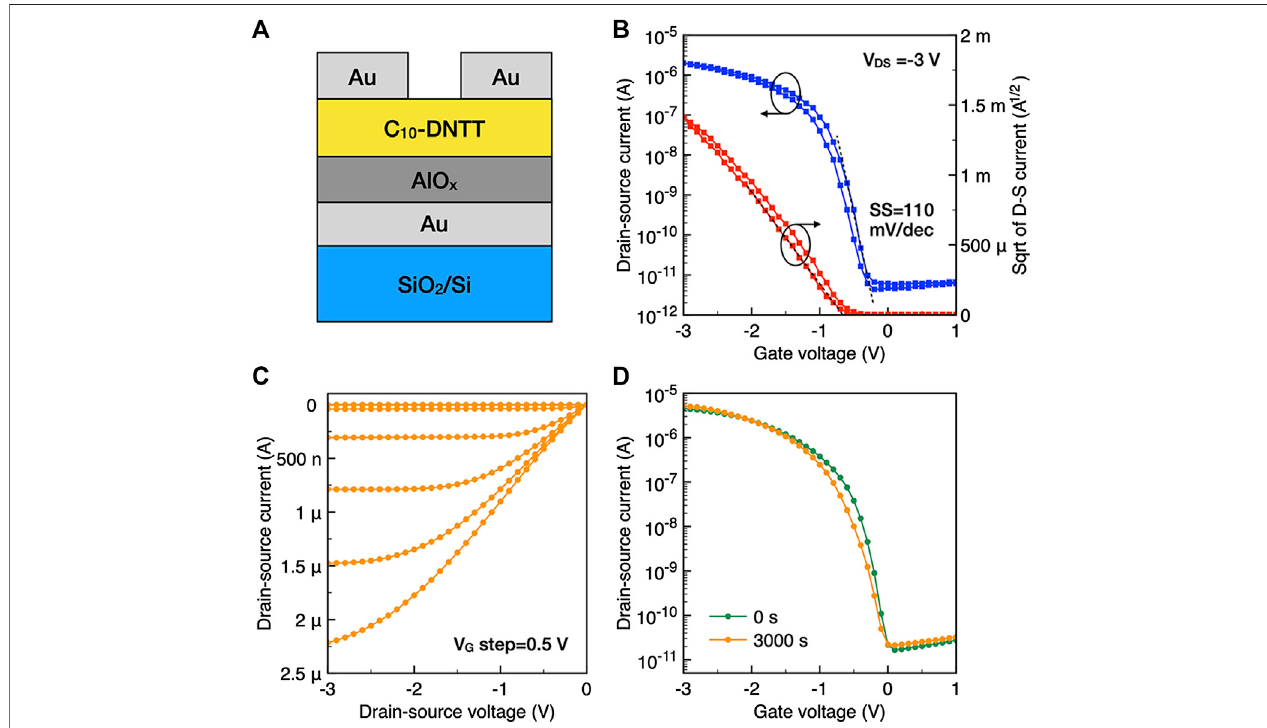
FIGURE 4 | (A) Schematic drawing of the organic transistor device structure. (B) Transfer I-V curve and square root of the drain-source current of the organic transistor. (C) Output I-V curve of the organic transistor. (D) Bias stress stability of the organic transistor.